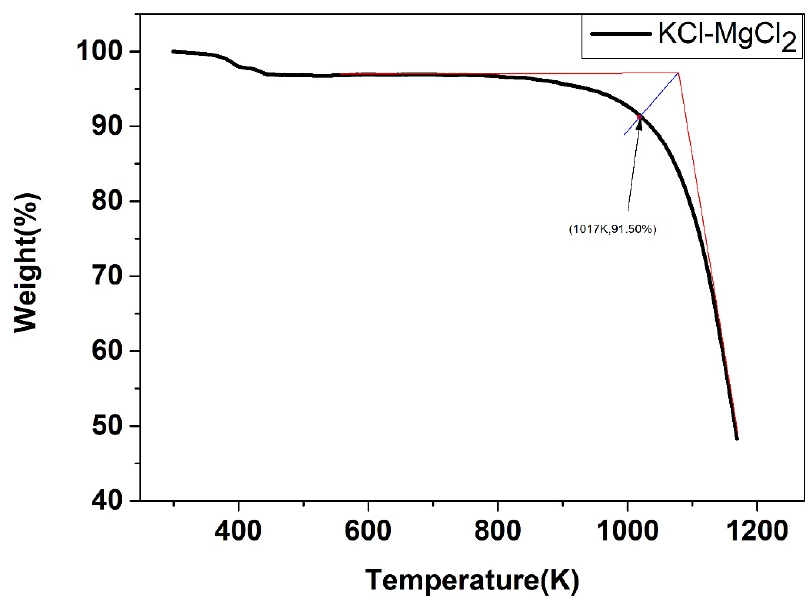
Figure 26. Weight change (wt.%) of the KCl ‐ MgCl 2 binary chloride salt.